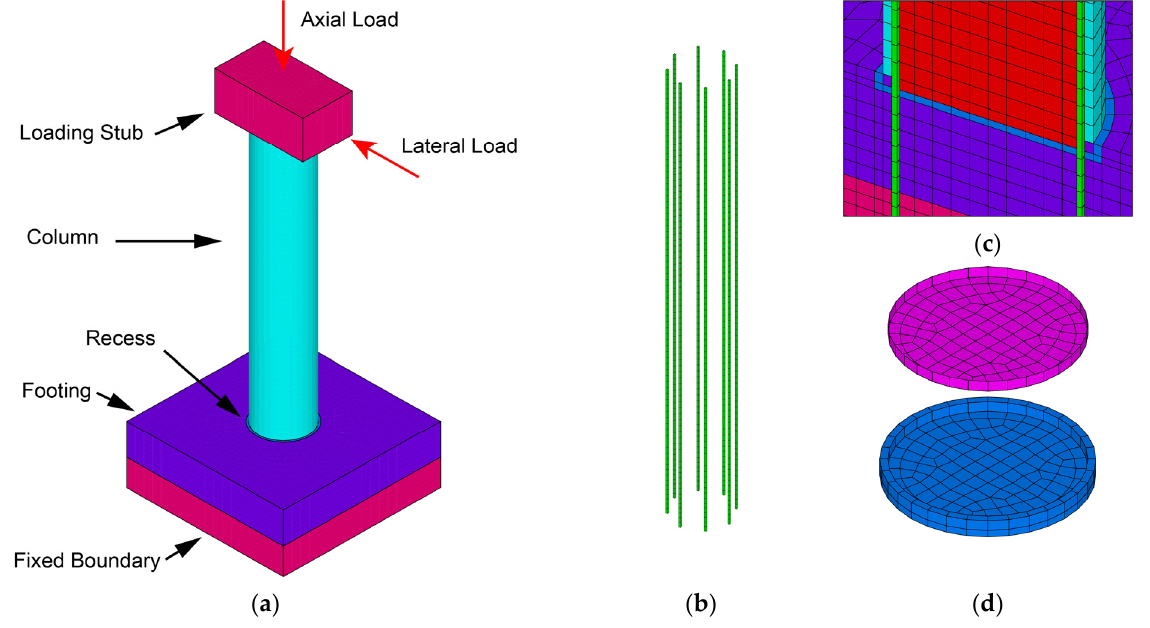
Figure 4. Numerical model of test specimen #1: ( a ) overall view; ( b ) longitudinal rebars; ( c ) recess and the mesh of profile; ( d ) contact and the mortar element.